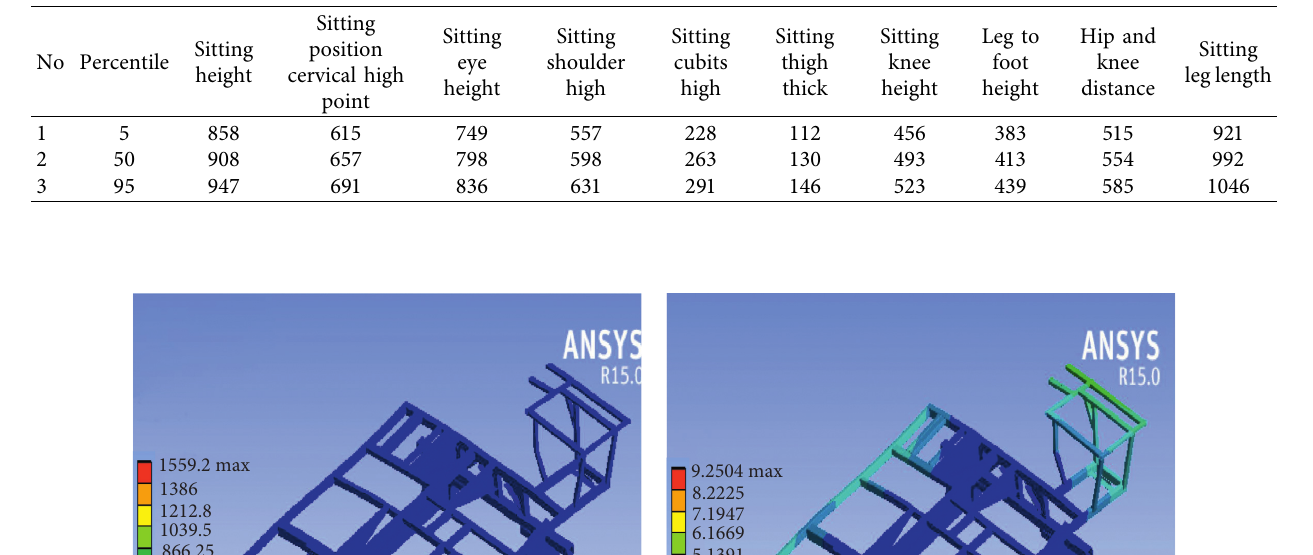
Table 3: Sitting variable of Chinese adult male human body (mm).